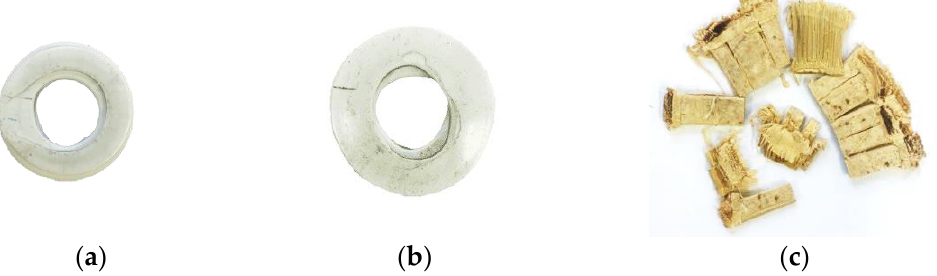
Figure 6. Shape of tube after deformation: ( a ) PVC Ø 20 ( b ) PVC Ø 25 and ( c ) Bamboo.